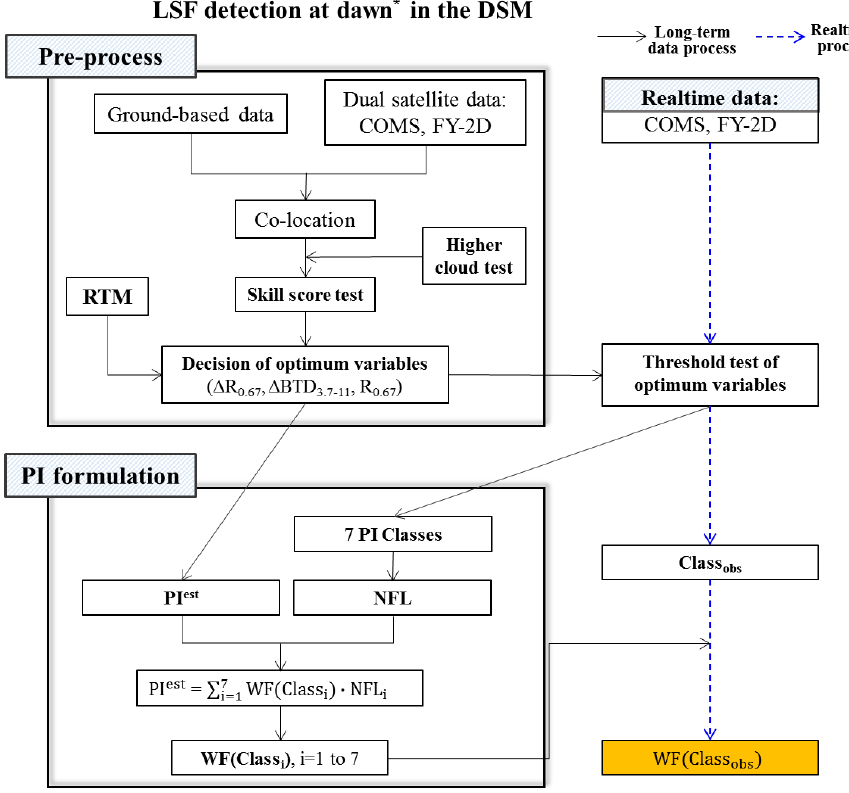
Figure 4. Flow chart for LSF detection in South Korea at dawn during the warm season (April-August) between April 2012 and June 2015, based on near-simultaneous satellite observations from COMS and FY-2D. The values of NFL, PI est , Class i and WF(Class i ) in a grid have been calculated from the long-term database (i.e., 18 months), while the values of Class obs and WF(Class obs ) over the real-time scene are assigned to one among seven classes of Class i and WF(Class i ), i = 1 to 7.